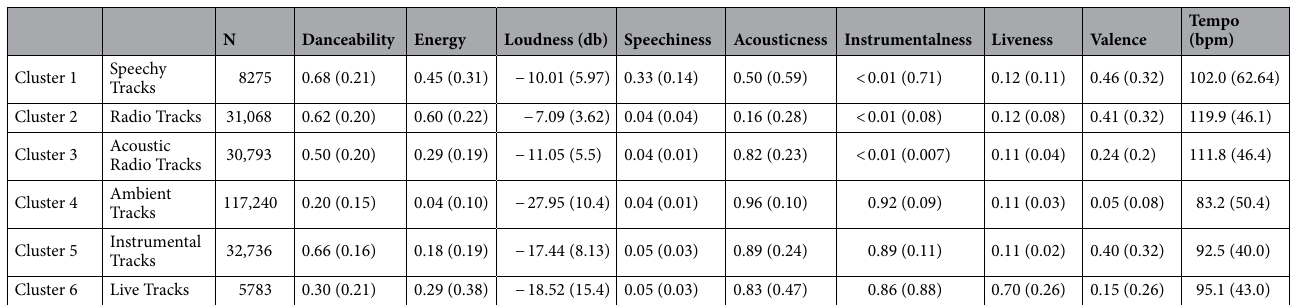
Table 5. Medians of all audio features for the 6 clusters of the Sleep